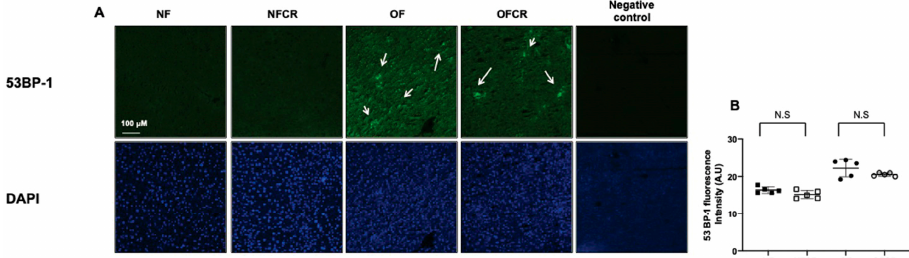
Figure 3. Liver DNA double-strand break evaluation in the NF, NFCR, OF, and OFCR groups at seven months of age. DNA double-strand breaks were evaluated by 53BP-1 staining at the same magnification (20 × ) in the NF, NFCR, OF, and OFCR groups ( A ). The presence of a DNA double stand break was observed in the OF and OFCR groups (arrows). Nuclei were counterstained with DAPI. A negative control was included. These pictures are representative images from n = 5 animals / group. 53BP-1 fluorescence intensity was quantified using ImageJ ( B ), N.S: nonsignificant, p >